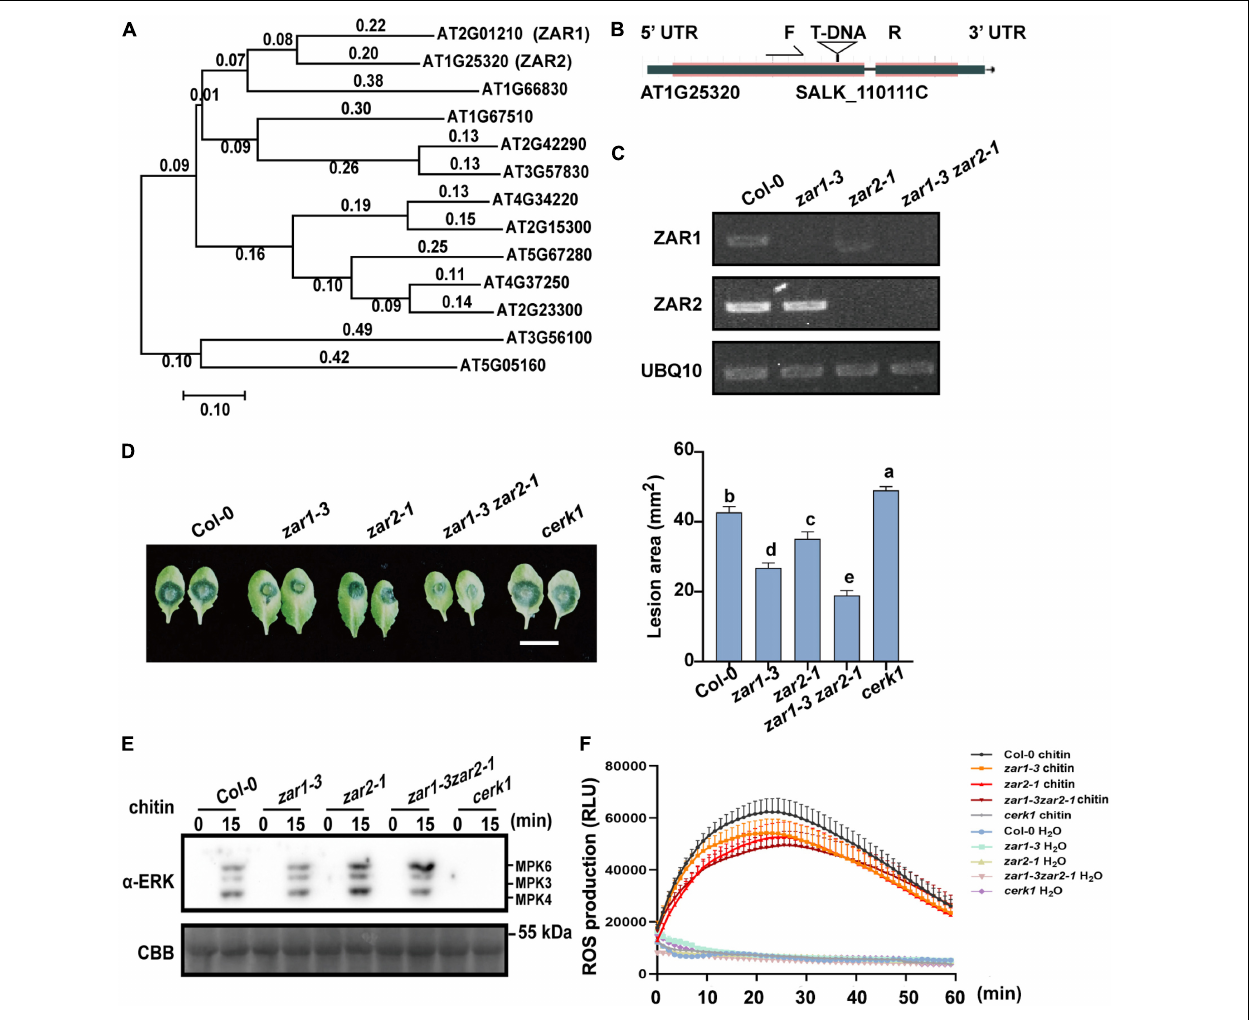
FIGURE 3 | ZAR1 and ZAR2 function redundantly in defense against B. cinerea. (A) The unrooted phylogenetic tree was constructed based on the full-length amino acid sequences of Arabidopsis proteins using MEGA 7 software by the Neighbor-Joining method. AT1G25320 (ZAR2) is most homologous to ZAR1. Scale bar is indicated. (B,C) Identification of zar1-3zar2-1 double mutant. zar2-1 (SALK-110111c) is a T-DNA insertion mutant in the Col-0 ecotype. zar1-3zar2-1 double mutant was obtained by crossing zar1-3 mutant with zar2-1 mutant. The transcription of ZAR1 and ZAR2 genes in this double mutant was examined by RT-PCR. UBQ10 was used as an internal control. (D) Both ZAR1 and ZAR2 negatively contribute to resistance against B. cinerea. Lesions on the leaves of zar1-3 mutant, zar2-1 mutant, cerk1 mutant, zar1-3zar2-1 double mutant, and Col-0 plants were observed at 72 h after inoculation with B. cinerea . Lesion sizes were analyzed. Error bars represent SEM from means of 16 leaves from each line. Different letters indicate significant difference at P < 0.05, as determined by one-way ANOVA with Tukey’s post-test. Scale bar = 1 cm. (E) Chitin-triggered MAPK activation in zar1-3 mutant, zar2-1 mutant, zar1-3zar2-1 double mutant, cerk1 mutant, and wild type Col-0. 10-day-old seedlings were treated with 200 µ g/mL chitin at the indicated time points. MAPK activation was detected with an anti-pERK antibody. cerk1 mutant was included as a control. Equal loading is demonstrated by CBB (Coomassie brilliant blue) staining of Rubisco (below). The experiments were repeated three times, with similar results. (F) Leaves of the 4-week-old zar1-3 mutant, zar2-1 mutant, zar1-3zar2-1 double mutant, cerk1 mutant, and Col-0 plants were treated with 200 µ g/mL chitin and incubated with luminol and horseradish peroxidase to detect ROS. Luminescence was recorded at different time points as indicated. Error bars represent SEM of data derived from replicate samples ( n = 12). The chemiluminescence was measured in a time-course manner using a microplate reader (Tecan-Spark,